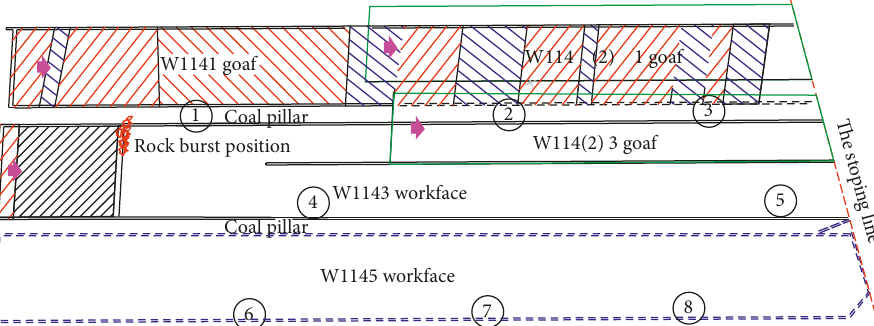
Figure 12: Location of coal mining face and layout of microseismic monitoring and measuring station.